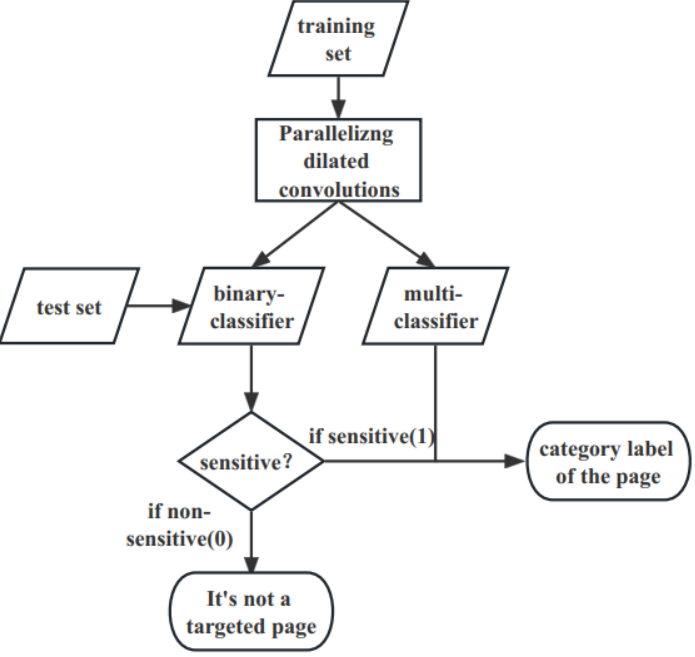
Figure 4. Detailed classification of Tor anonymous traffic.